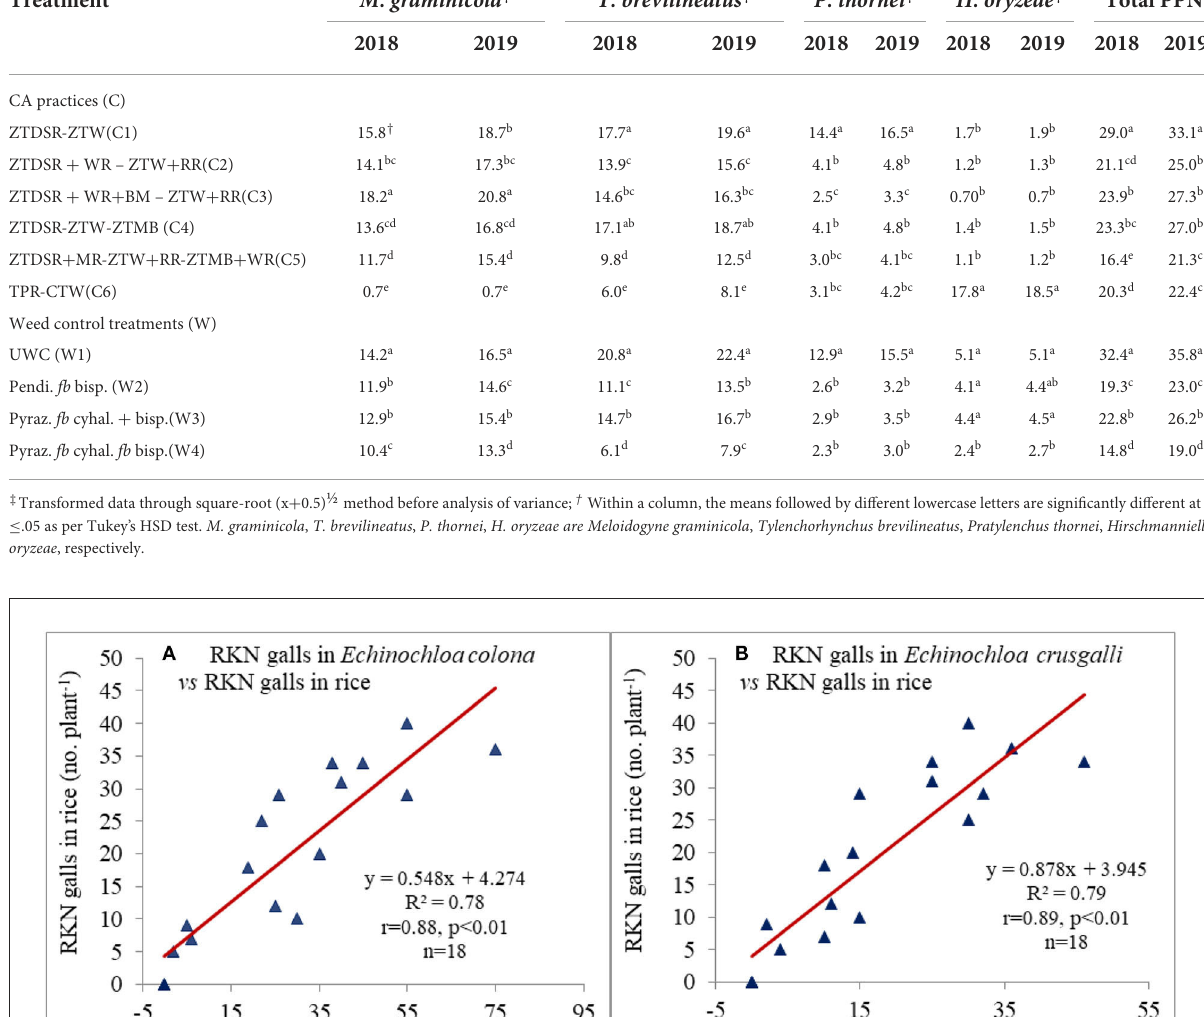
also reduced weeds. Three crops (rice, wheat, and mungbean) residues under the mungbean-inclusive triple ZT system (C5) led to a considerable reduction in C. esculentus and C. rotundus